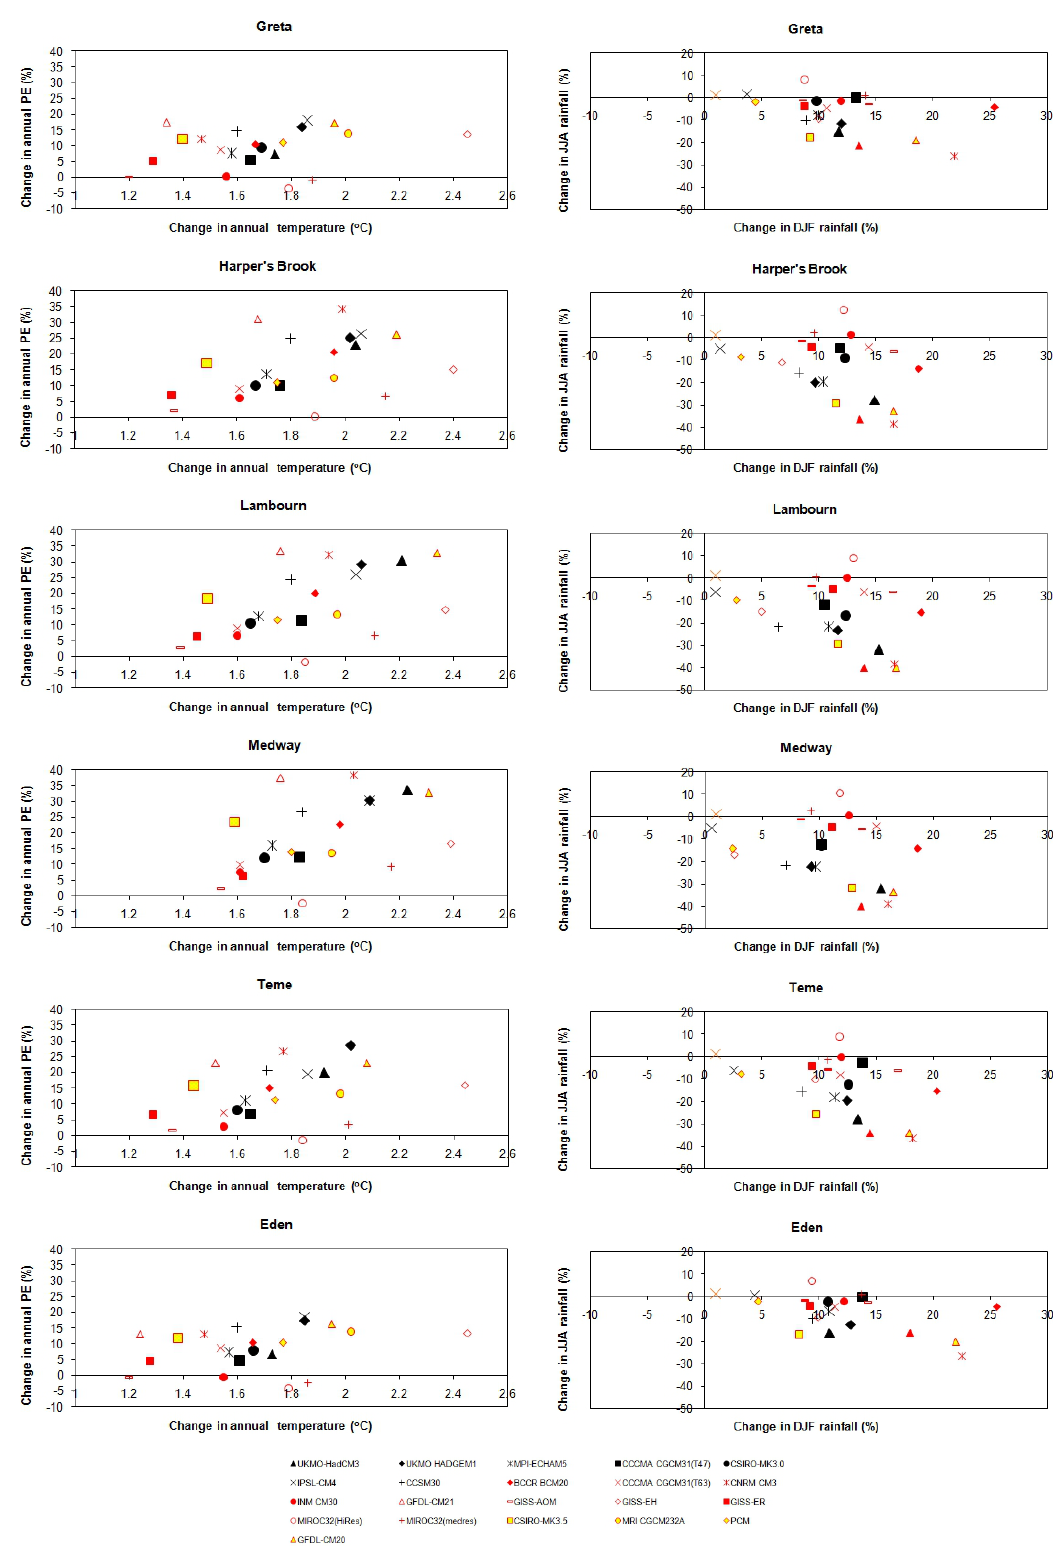
Fig. 3. Change in climate characteristics for each catchment, for a 2 ◦ C rise in global mean temperature. Left panel: change in mean annual temperature and mean annual potential evaporation. Right panel: change in mean winter and summer rainfall. The seven priority scenarios are